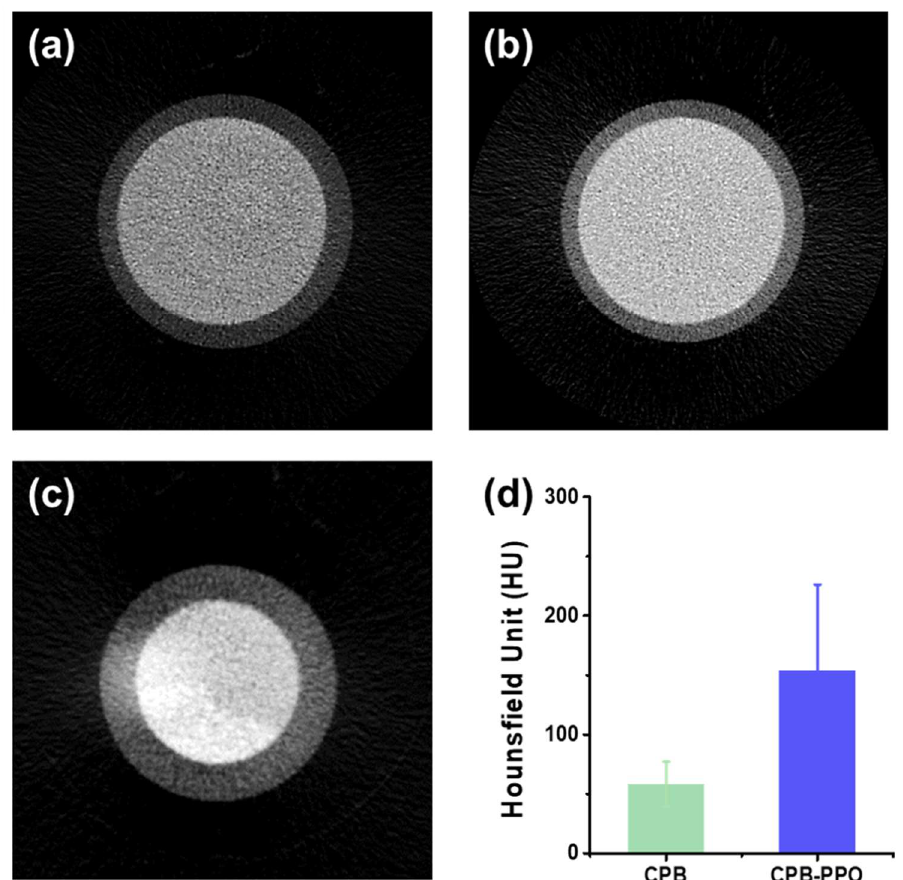
Figure 3. ( a – c ) Micro-computed tomography (CT) images of water ( a ), the CPB/SiO 2 NP solution ( b ), and the CPB–PPO/SiO 2 NP solution ( c ). The concentrations of both NP solutions were 1.0 mg/mL in water. ( d ) Hounsfield units of the CPB/SiO 2 and CPB–PPO/SiO 2 NP solutions.